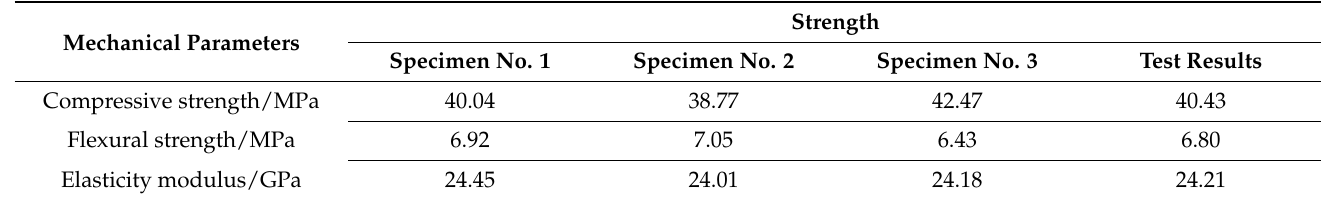
Table 6. Basic mechanical indices of ceramsite concrete after 28-d